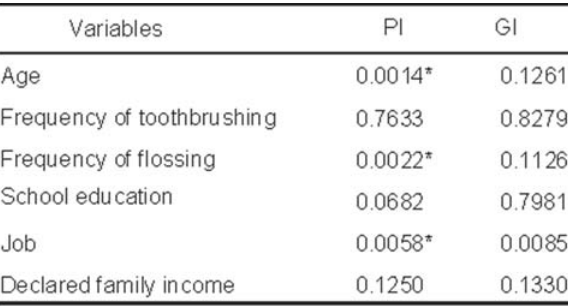
TABLE 4- Covariance analyses for mother’s total plaque and gingival